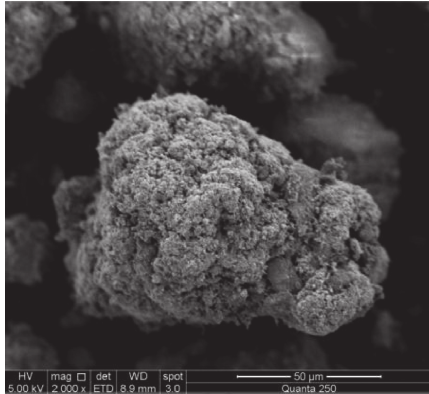
Figure 5: SEM image of the ZnO/sepiolite composite prepared by the hydrolytic precipitation